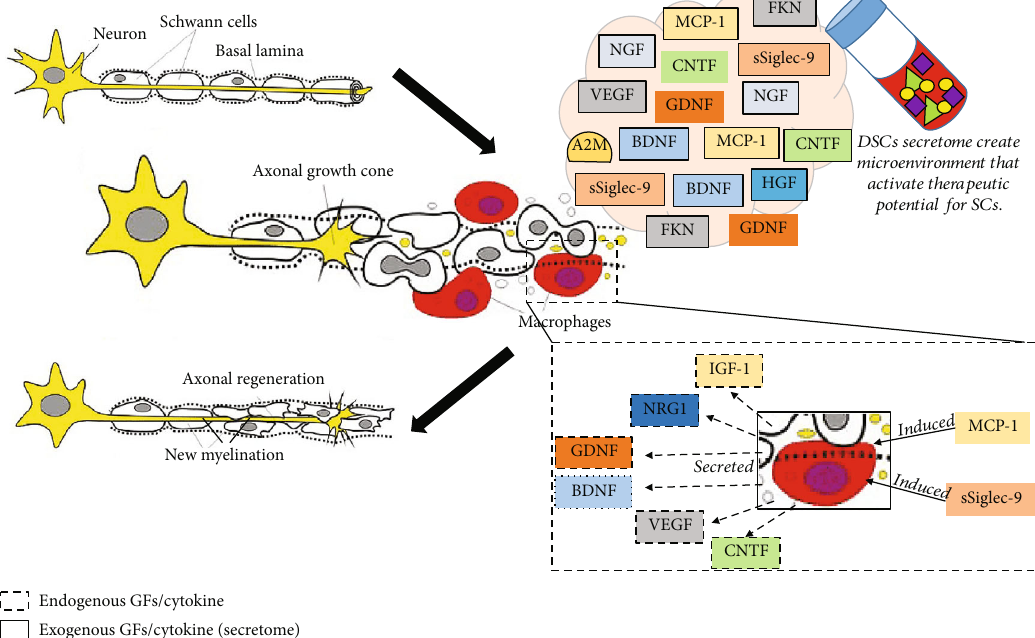
Figure 3: Schematic illustrating the role of DSC secretomes modulating the nerve regeneration in CNS. Alzheimer ’ s disease (AD) responds to the production of β -amyloid fi bres/plaque which triggers the microglia and astrocytes activation and generation of proin fl ammatory cytokines. The chronic activation of microglia and astrocytes causes neuron degeneration. Stimulation by GFs and cytokine derived from DSCs secretome such as A2M cytokine is capable of binding to β -amyloid fi bres/plaque that mediate the clearance and degradation [1] while FKN can execute their phagocytic functions. In addition, Siglec-9 and MCP-1 can switch the M1 to M2 phenotype for nerve regeneration. This would enhance neuronal plasticity and neurogenesis in AD patients.